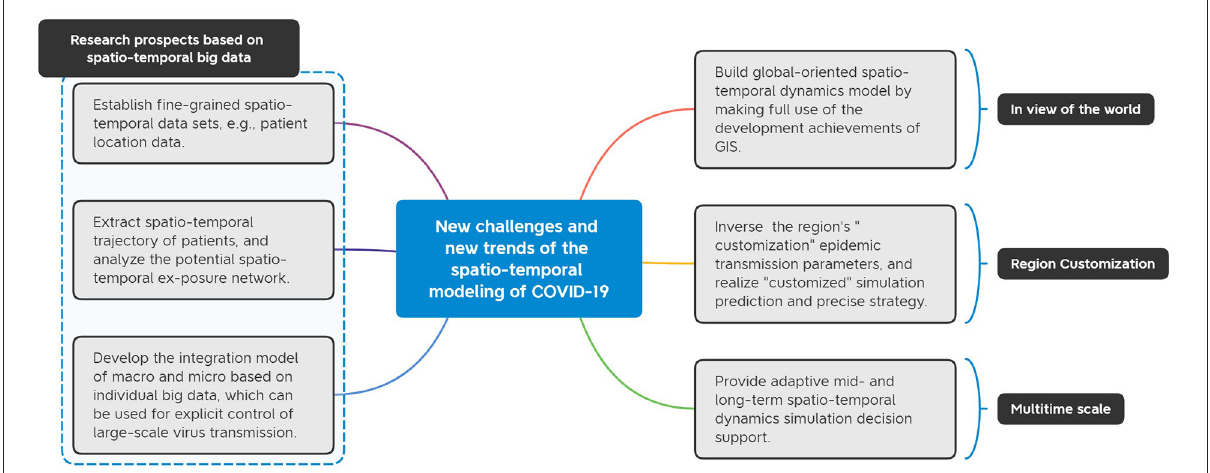
FIGURE6 Prospects for future research on COVID-19 spatio-temporal dynamics models. The challenges and trends of building global-level models, making regional customized forecasts, providing multi-time-scale decision support, and developing model reproducibility based on spatiotemporal big data are